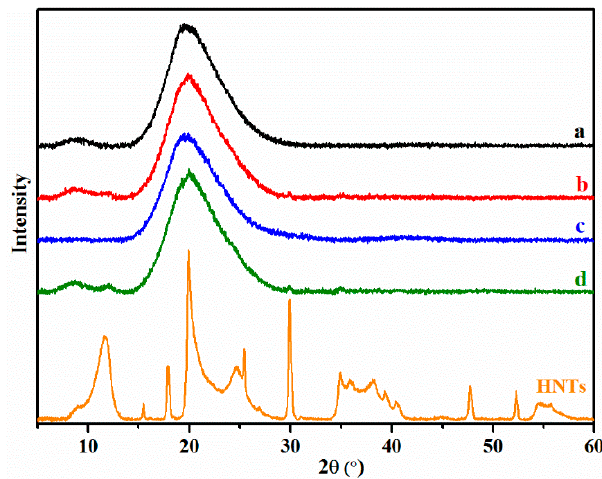
Figure 5. X-Ray diffraction (XRD) of the HNTs and SPI-based films: SPI and PTGE film a ; SPI, PTGE, and HNTs film b ; SPI, PTGE, and CMCS film c ; SPI, PTGE, HNTs, and CMCS film d .